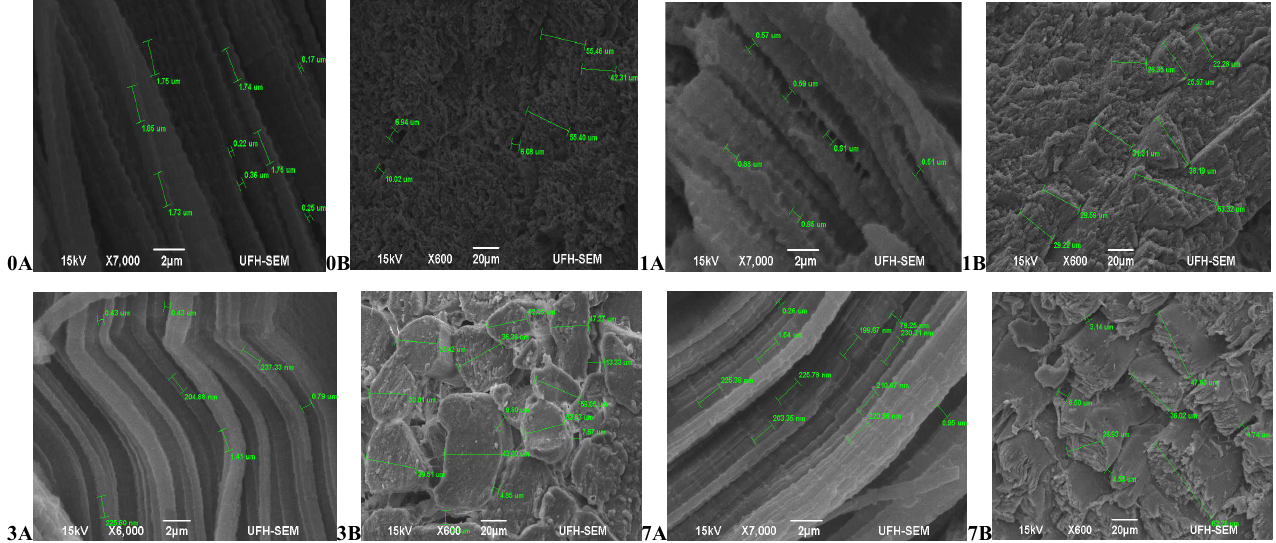
Figure 3. Transverse and Lateral muscle nanostructure changes of Hereford during a 7 day ageing period; observed under the JEOL JSM-6390LV scanning electron microscope (SEM) and further viewed using JEOL JM-5600 SEM at ×5,000 magnification. A, Lateral muscle structure from day 0, 1, 3, and 7 ageing period; B, transverse muscle structure from day 0, 1, 3, and 7 ageing period. μm, micrometre.